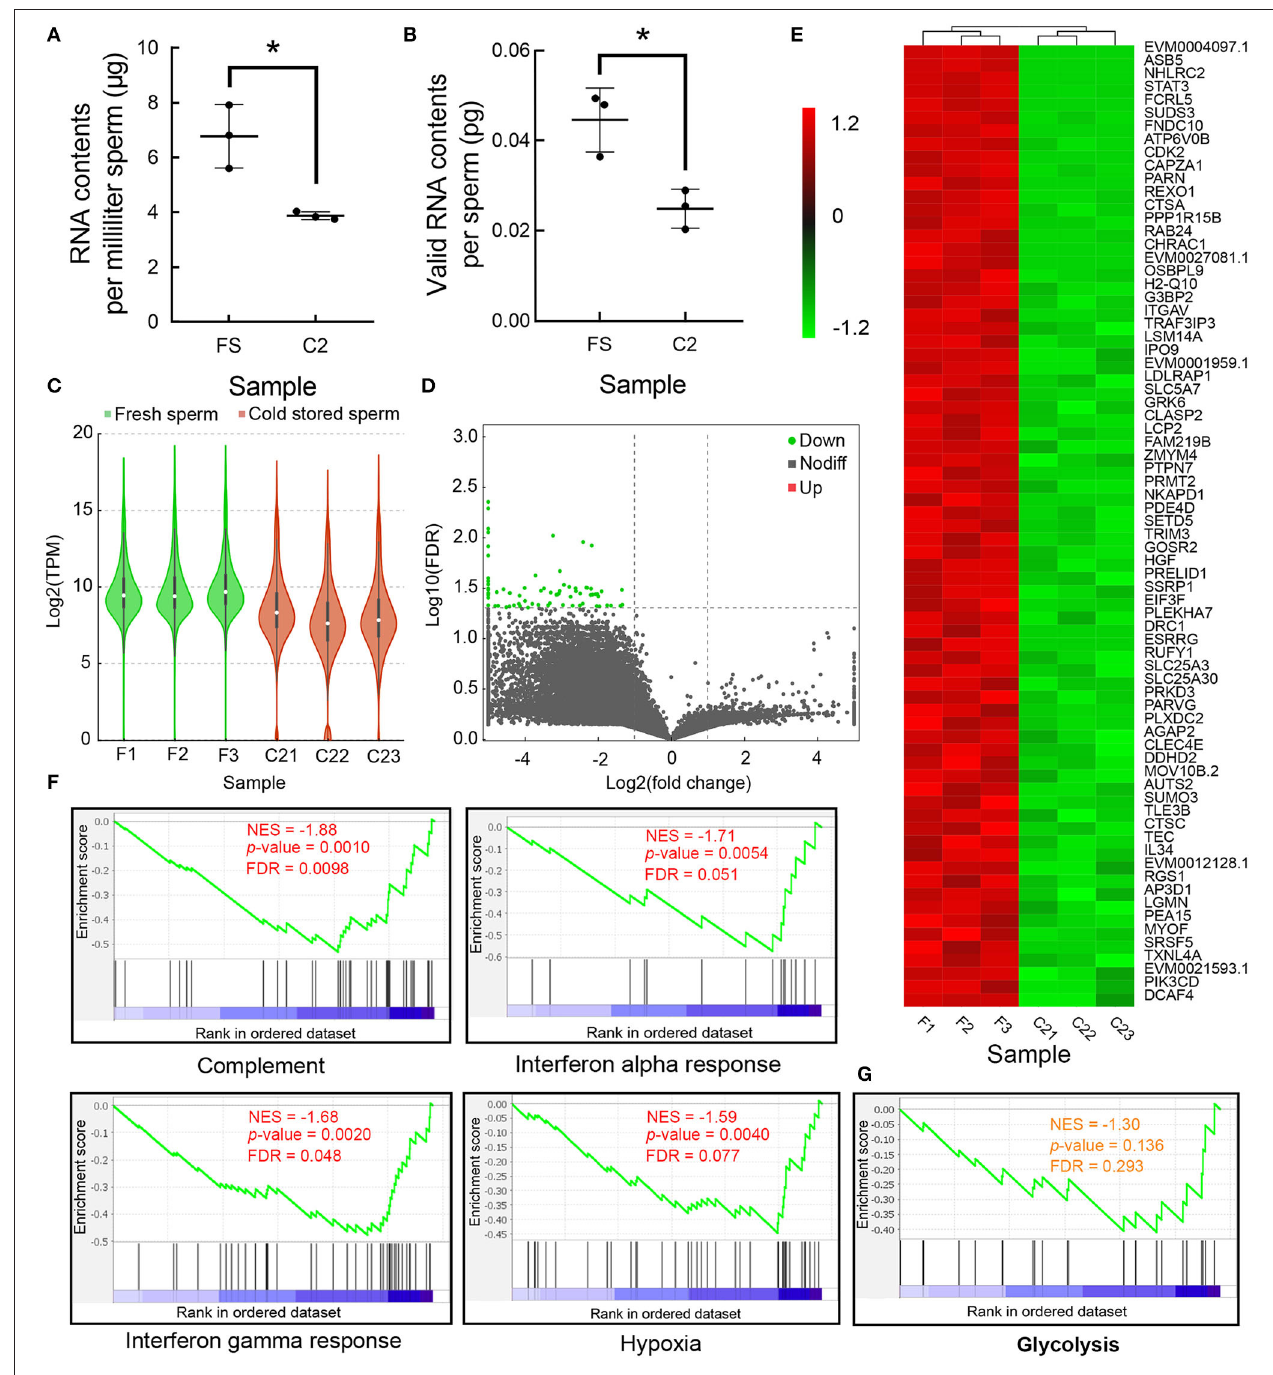
FIGURE 3 | The changes of messenger RNAs (mRNAs) during cold storage. (A) The changes of RNA contents per milliliter fresh sperm (FS) and C2. (B) The changes of RNA contents per sperm at FS and C2. (C) The changes in the TPM transcripts during cold storage. (D) The volcano graph of all transcripts. Green indicates the downregulated differentially expressed genes (DEGs). (E) The heatmap of DEGs. (F) The four most-enriched gene set during cold storage based on GSEA. (G) The enrichment of transcripts involved in glycolysis. Asterisk indicated significant difference ( p <